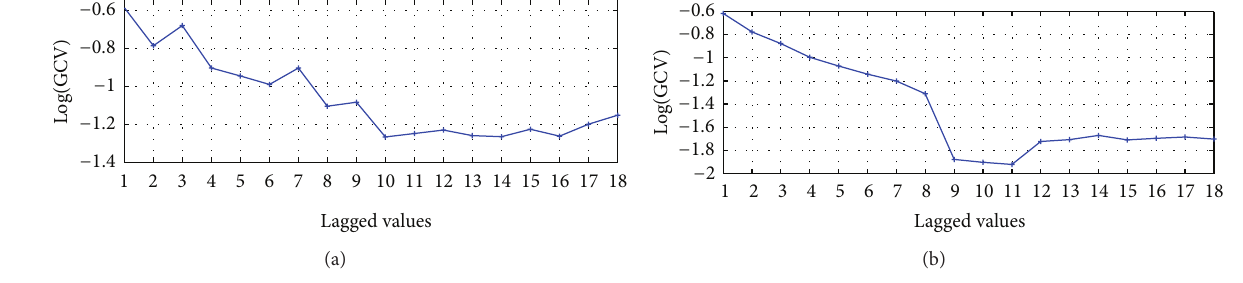
Figure 3: (a) MA smoothing and (b) HSVD smoothing.